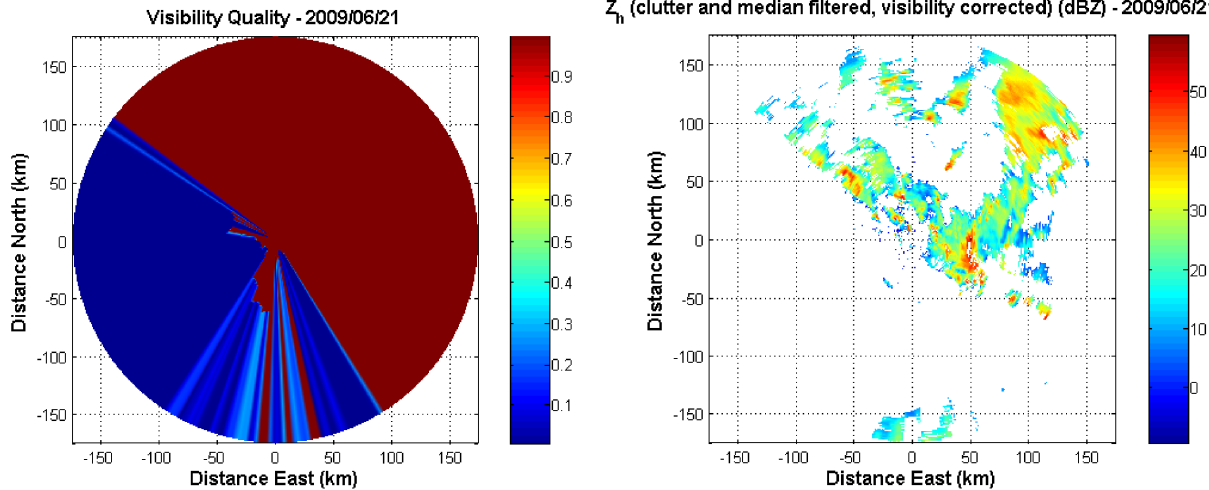
Fig. 5. Quality map associated with partial beam blocking for radar “Il Monte”, on 21 June 2009, at 14:00 UTC, elevation 0.4 (left), and the corresponding reflectivity (see Fig. 1) corrected for clutter, filtered with a two-dimensional median filter and corrected for partial beam blocking (PBB < 0.7)